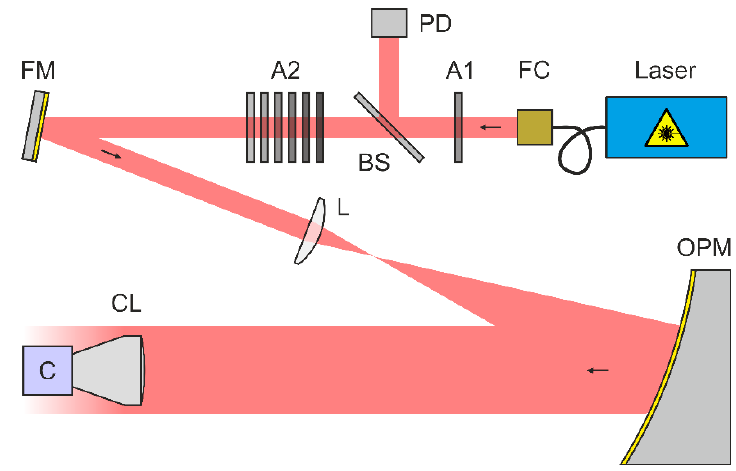
Figure 4. Scheme of the experimental setup for the measurement of irradiance distribution in the focal plane of camera lenses. FC: fiber collimator, A1/A2: attenuator, BS: beam splitter, PD: (reference) photodiode, FM: folding mirror, L: focusing lens, OPM: off-axis parabolic mirror, CL: camera lens, C: camera.